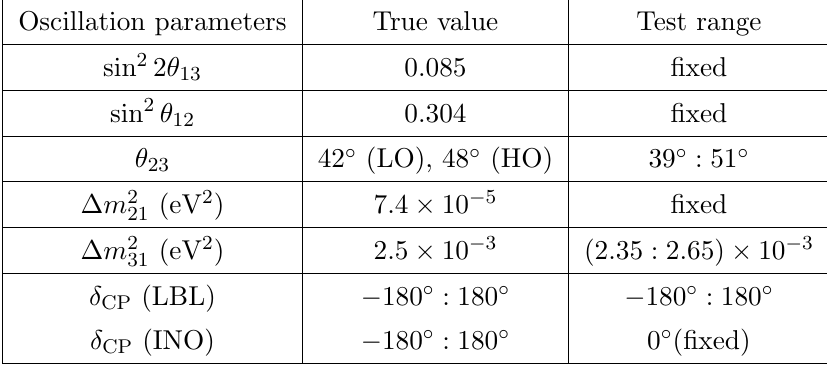
Table 4 . The true and test values of the oscillation parameters used in our